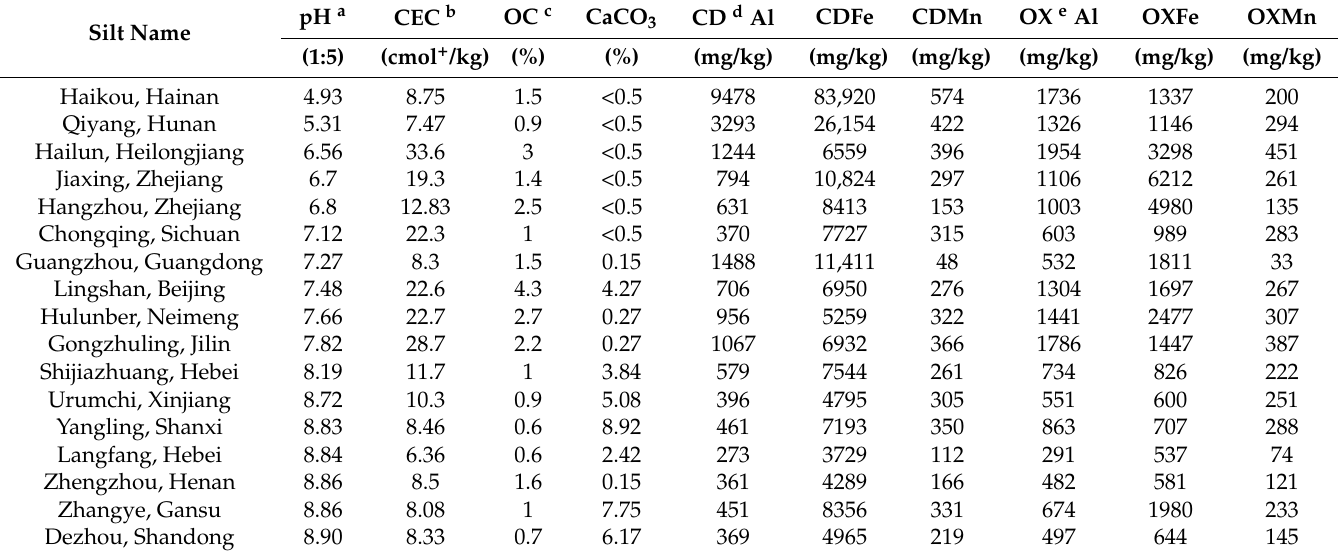
Table 1. Main properties of the soils used in this